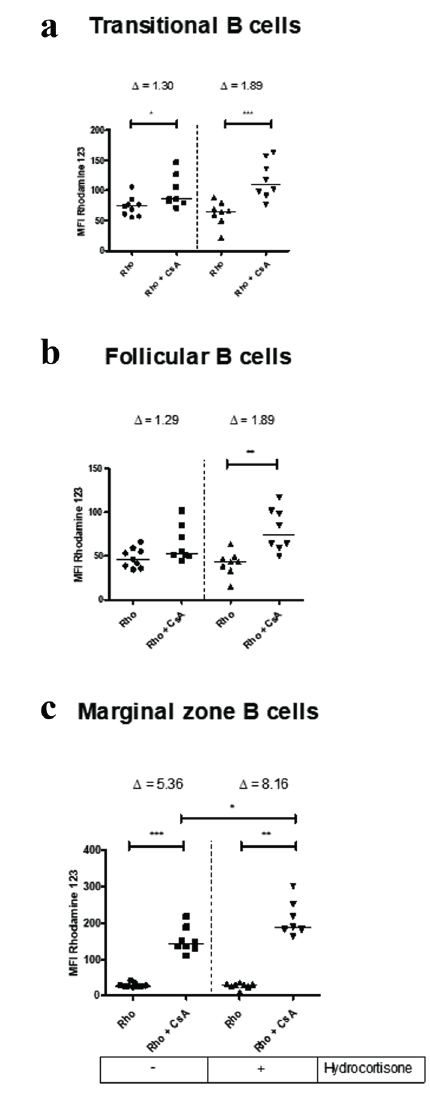
Figure 7 - Effect of in vivo treatment with hydrocortisone on ABCB1 efflux activity of subsets of spleen B cells. Mice were injected with diluent or hydrocortisone (140 mg/kg/day) for 3 consecutive days. In the next day, mice were injected with cyclosporin A (CsA, 100 mg/kg) and, one hour later, with rhodamine 123 (Rho, 2.5 mg/kg), as described in materials and methods. Spleen cells were counted and stained with monoclonal antibodies for CD19, CD21 and CD23 molecules for analysis by flow cytometry. ( a ) Median fluorescence intensity for rhodamine 123 on transitional B, ( b ) follicular B, ( c ) marginal zone B cells. Line represents the median, ∆ values represent mean of transport reversal index (Δ=MFI Rho+CsA/ MFI Rho), (*) represents values of p < 0.05, (**) p < 0.01 and (***) p < 0.001, according to the statistical test. Results are representative of 3 independent experiments with 2-3 mice/ group